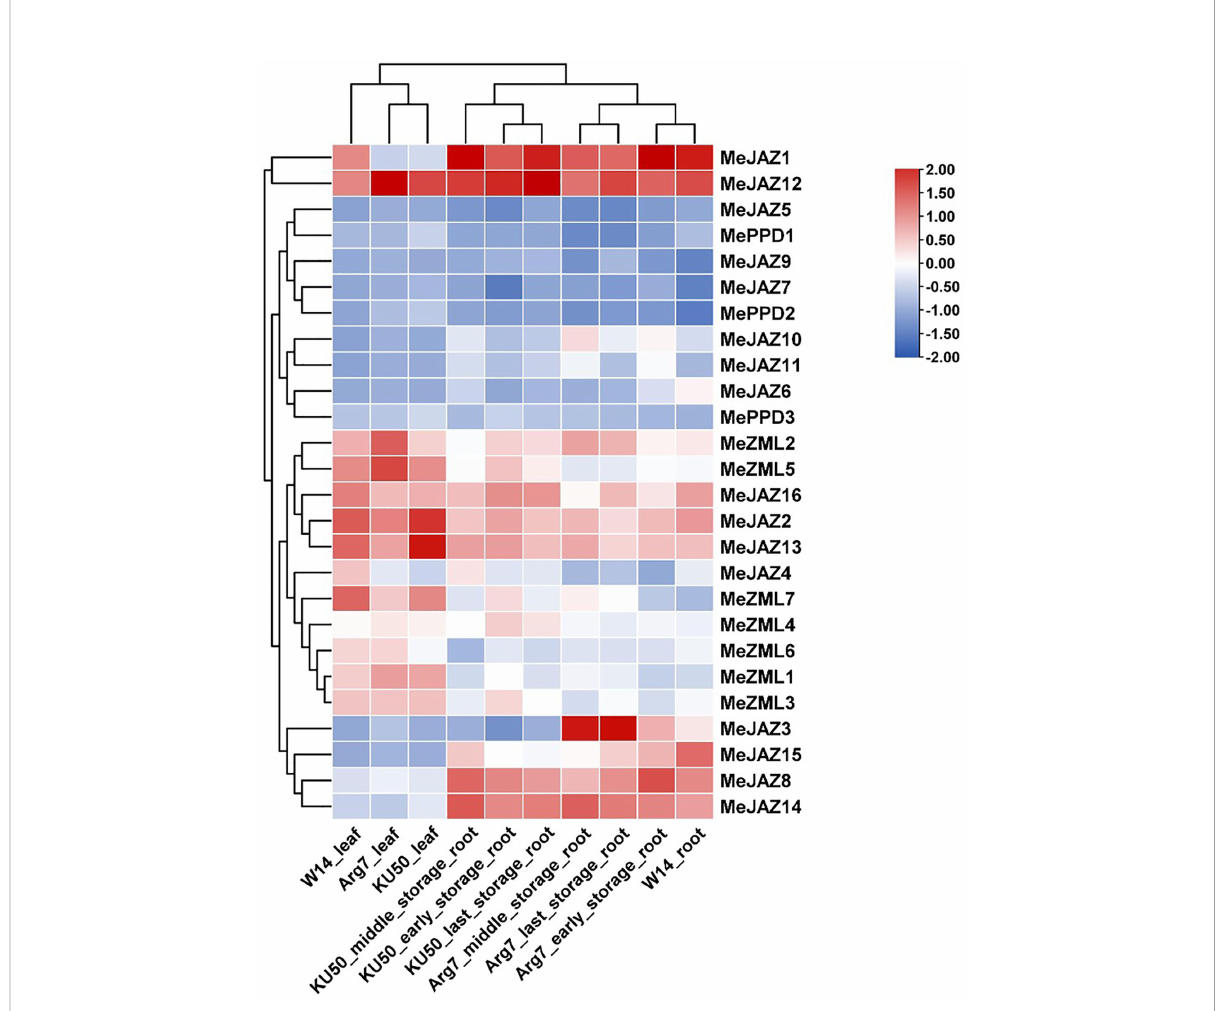
FIGURE 6 Expression pro fi les of cassava ZML, PPD and JAZ genes in leaves and roots of Argentina 7 (Arg7), wild subspecies (W14), and Kasetsart University 50 (KU50). Log2 transformed FPKM value was used to create the heat map. The scale represents the relative signal intensity of FPKM